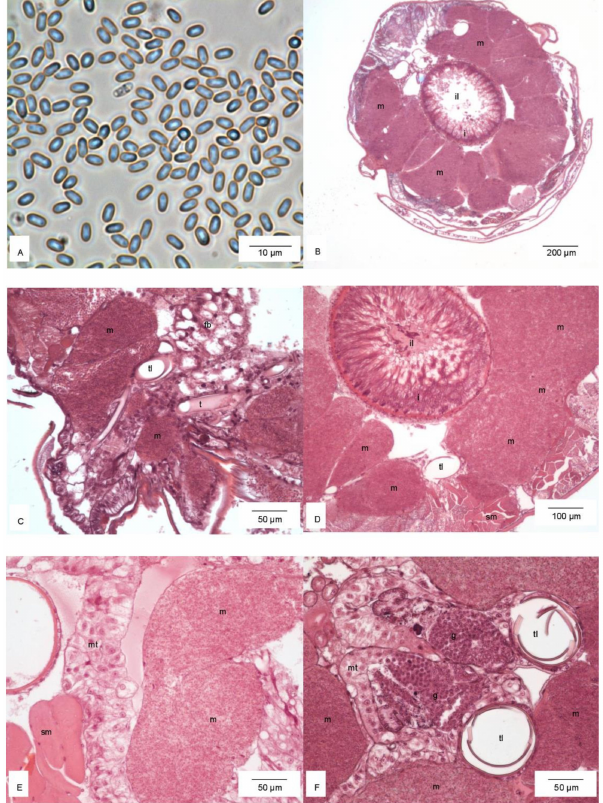
Figure 3. Microsporidia ( A ). Cross-section through the thorax ( B ). Hypertrophied cells of the fat body filled in by microsporidia and the surrounding noninfected fat body ( C ), intestine ( D ), Malpighian tubules ( E ), and germ gonads ( F ). Abbreviations: fb, noninfected fat body; g, germ gonads; i, intestine; il, intestinal lumen; m, hypertrophied cells of the fat body with microsporidia; mt, Malpighian tubules; sm, striated muscles; t, tracheal tube; tl, tracheal